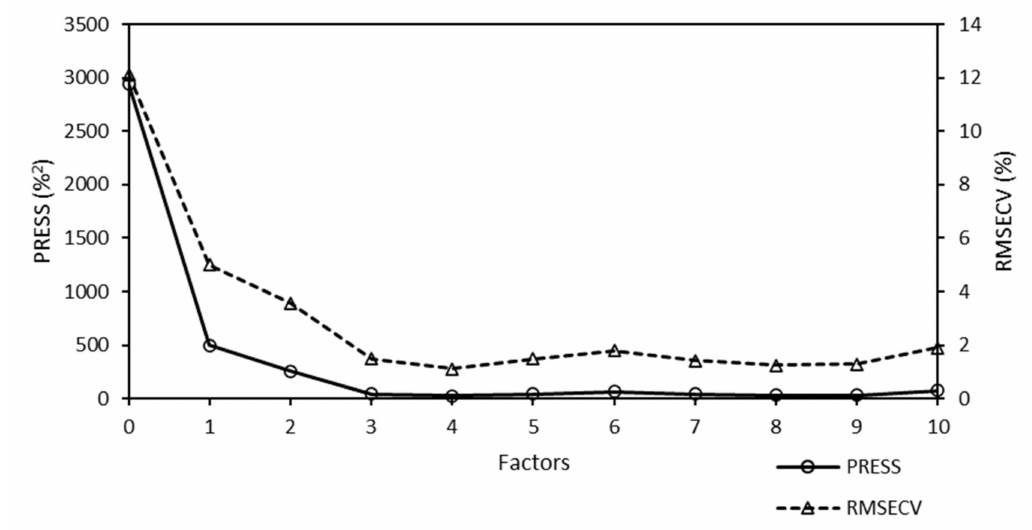
Figure 8. Predicted residual error sum of squares (PRESS) diagnostic function of the Raman model used for the analysis of the W content of W-supported mesoporous silica catalysts. The minimum PRESS / RMSECV value was achieved using four factors. Here, RMSECV denotes the root mean square error of